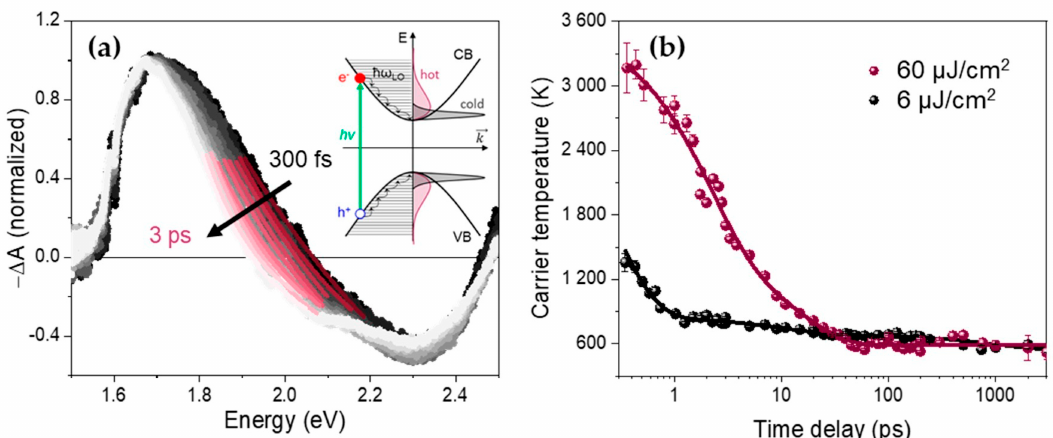
Figure 2. ( a ) Normalized transient absorption (TA) spectra of thick FAPbI 3 NPs during the first 3 ps (dots, excitation 630 nm, 160 µ J / cm 2 , chirp-corrected, see Supplementary Materials). The high-energy tail fitting is shown in wine-colored solid lines. Inset: schematics of the relaxation from a hot to cold charge carrier distribution in the case of a continuum of energy levels above the bandgap. ( b ) Time-dependent carrier temperatures T c of FAPbI 3 NPs extracted over five decades of time from the TA spectra for a 630 nm pump excitation at 6 µ J / cm 2 (black dots) and 60 µ J / cm 2 (wine-colored dots) using the conventional tail-fitting method. The multiexponential fits of these decays are displayed with solid lines (parameters in Table 1).